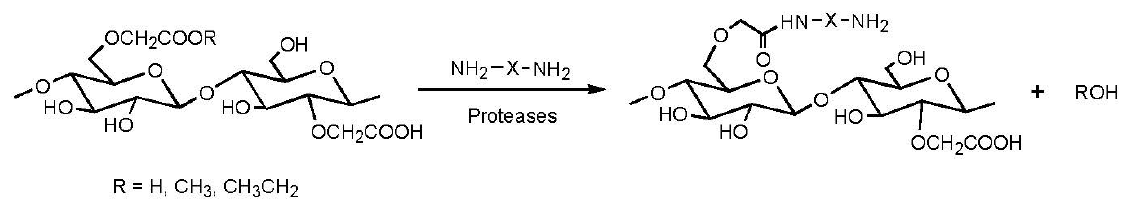
Figure 4. Hydrolase-catalyzed amidation of carboxymethylcellulose (CMC) and CMC